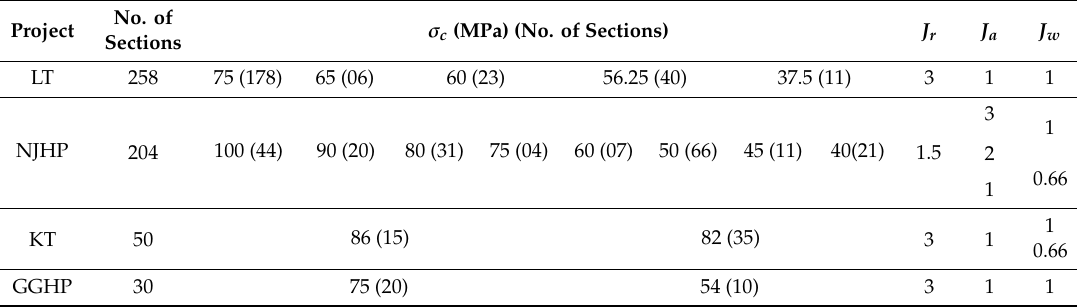
Table 5. Number of sections along with known parameters of tunneling quality index system for the four projects.